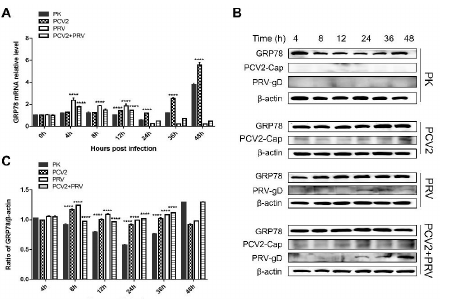
Figure 4. GRP78 is upregulated during PCV2 and/or PRV single- and coinfection. PK-15 cells (PK) were single- or co-infected with PCV2 and/or PRV for 4, 8, 12, 24, 36, and 48 h. The expression levels of GRP78 were assessed by real-time PCR ( A ) and Western blotting ( B , C ). ****, p -value < 0.0001. β -actin was used as a control. The relative amount of GRP78 to β -actin was quantified by densitometry analysis using ImageJ software ( C ). GRP78 (Affinity, Jiangsu, China, 1:2000), PRV-gD (Lvdu, Shandong, China, 1:500), PCV2-cap [31] , and β -actin (Proteintech, Wuhan, Hubei, China, 1:10,000) were used as primary antibodies, respectively. Unprocessed original images can be found in Supplementary Figure S1. 3.5. PCV2 and PRV Infection Does Not Affect the Activation of the ATF6 Pathway GRP78 can directly interact with three ERS sensors, ATF6, IRE1, and PERK, to regulate the UPR signaling pathways, and therefore activate ERS [25]. To clarify the downstream molecule of GRP78 during the PCV2 and PRV infection, expressions of ATF6